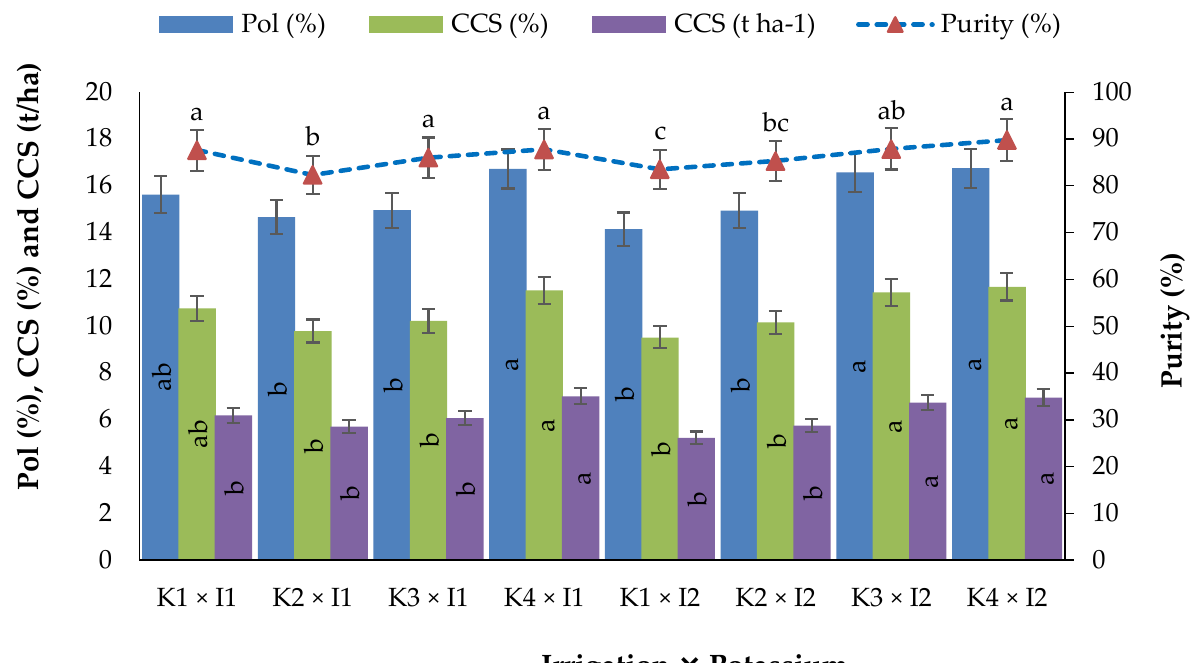
Figure 3. Interaction effect of different irrigation and potassium levels on quality parameters of sugarcane 8 months after harvest. Different letters within the bars and the line indicate significant differences at 1% level of probability.